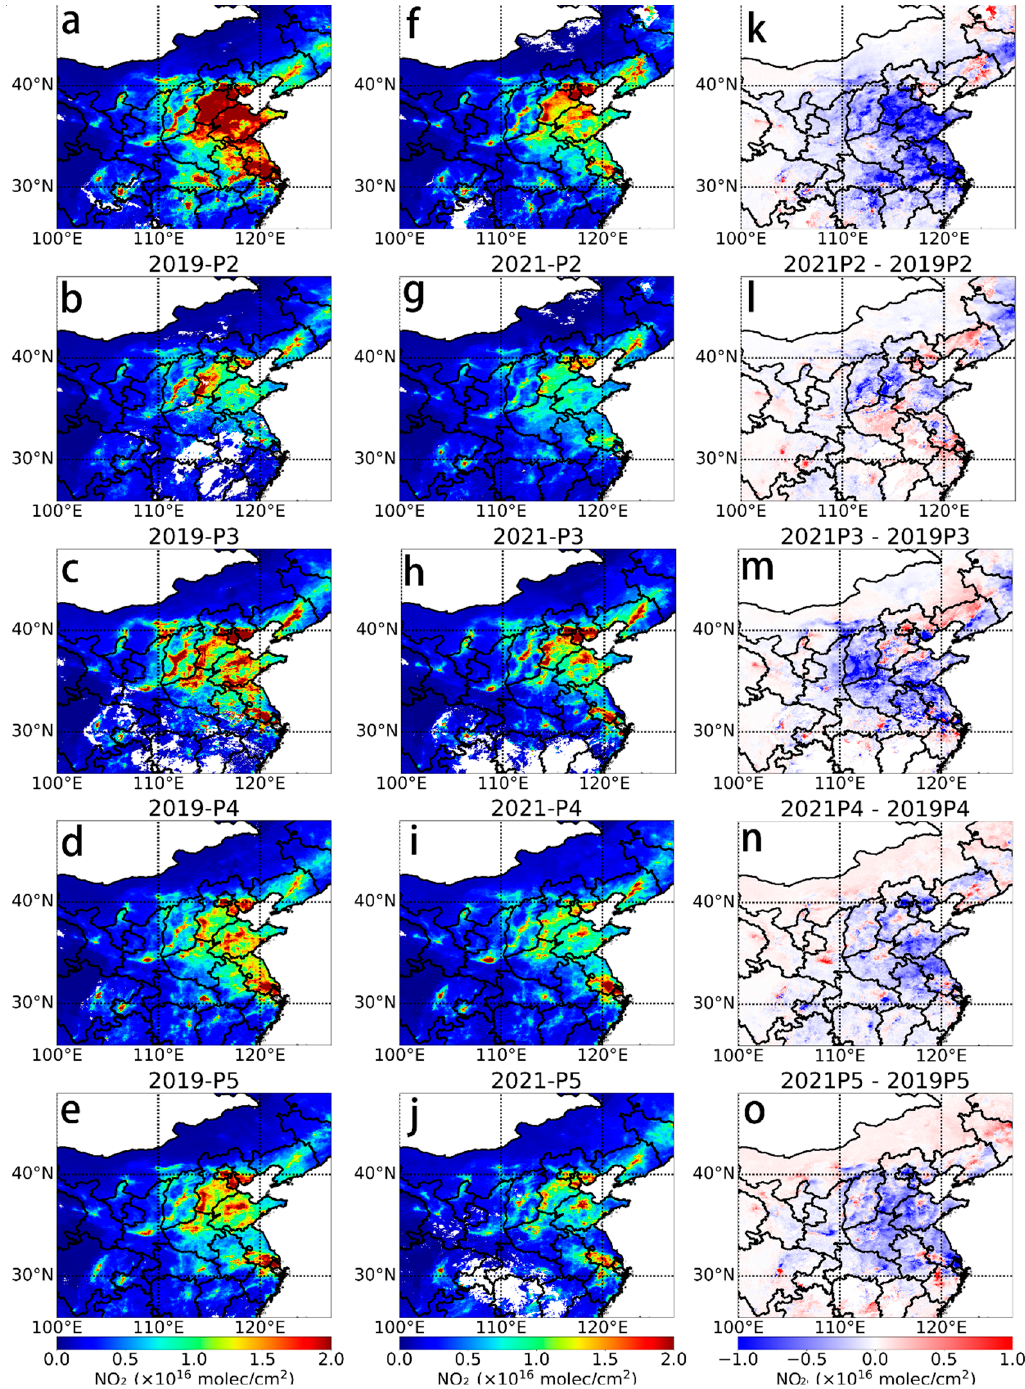
Figure 7. Distribution of the NO 2 TVCD for the same period (15-day average) in 2021 vs. 2019. ( a – e ) P1-P5 in 2019, ( f – j ) P1-P5 in 2021, ( k – o ) P1-P5 differences between 2021 and 2019.